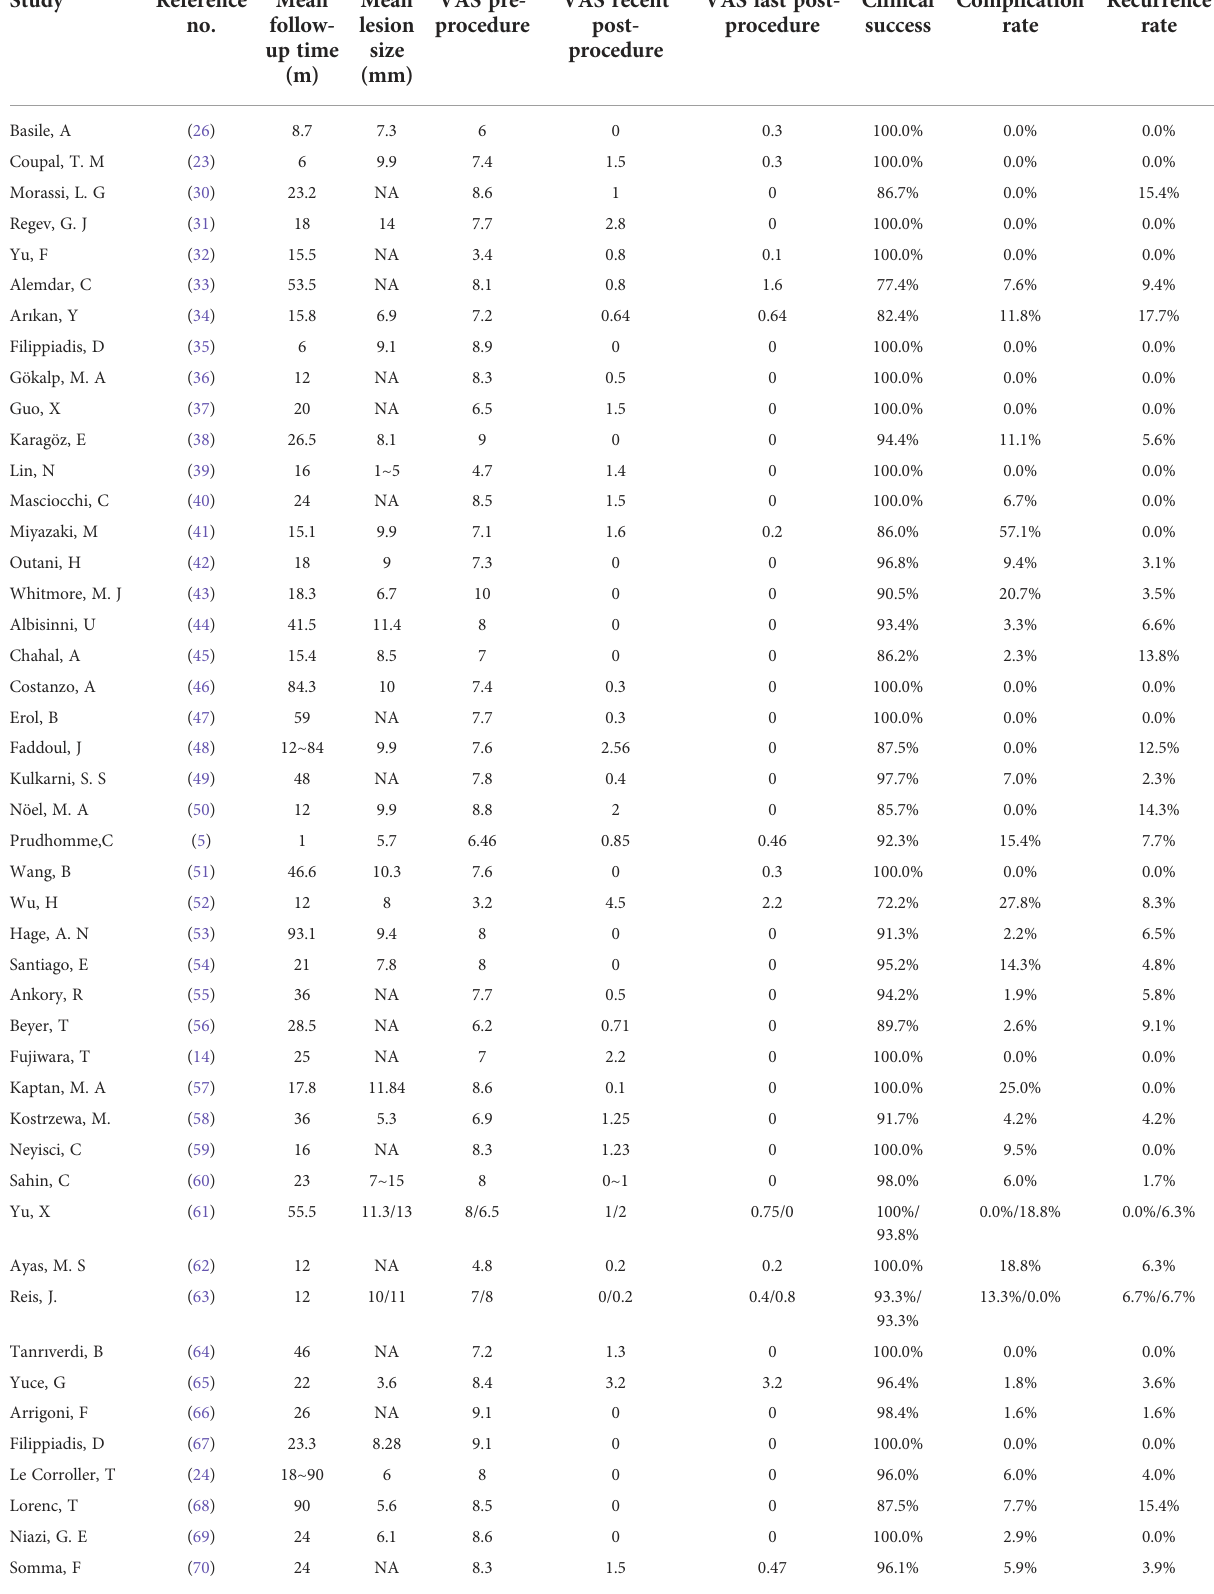
TABLE 1 Characteristics of the results of each study.